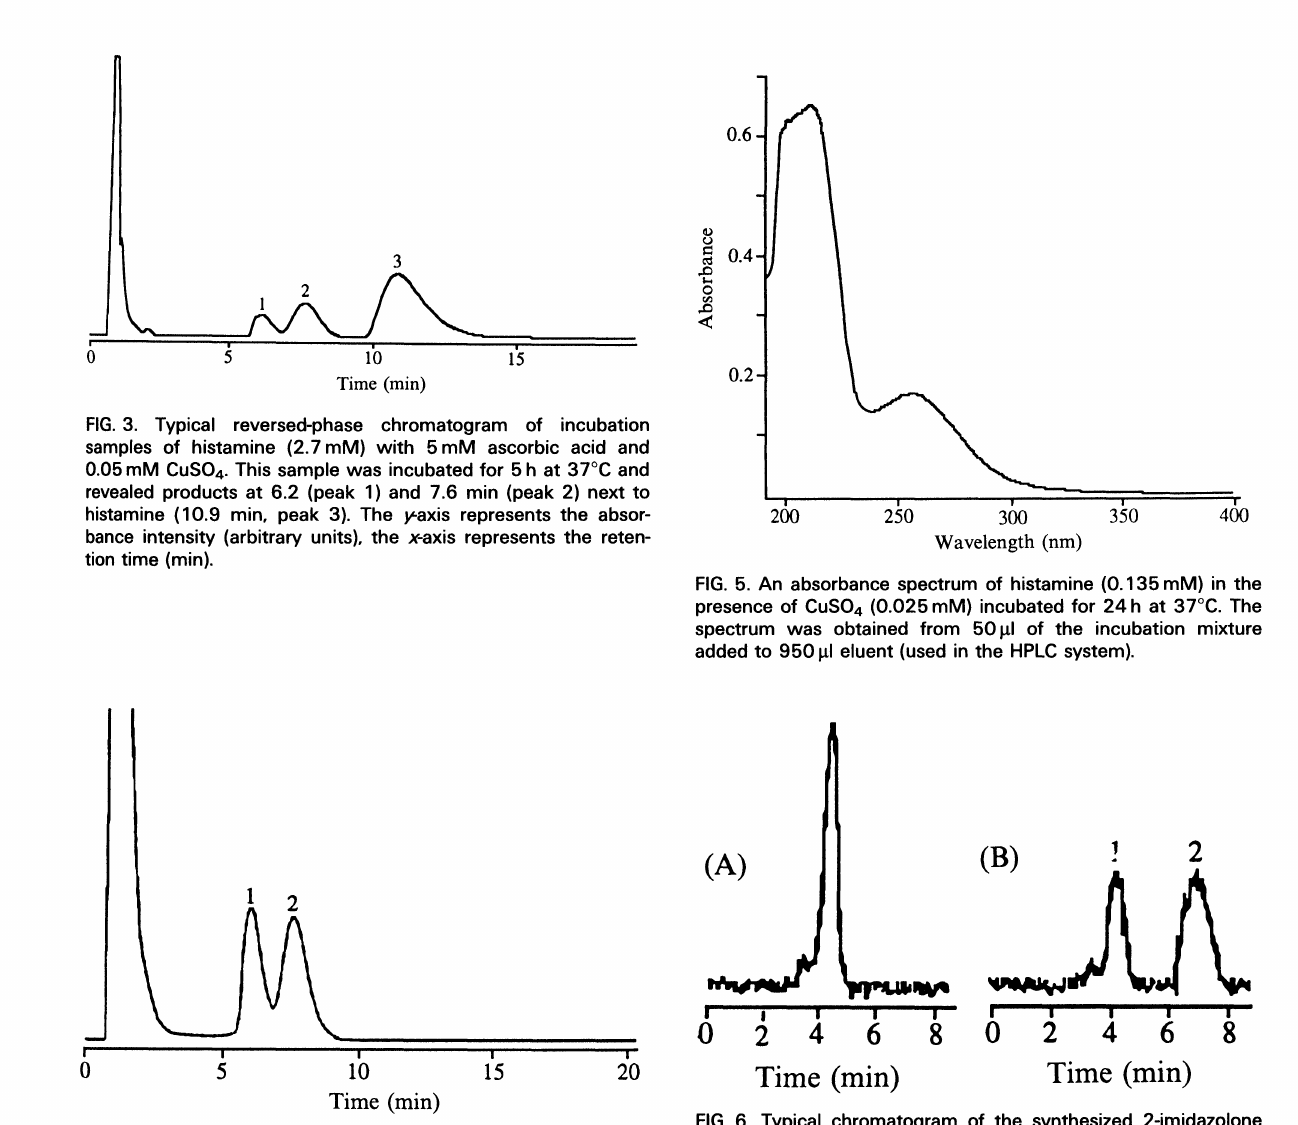
FIG. 6. Typical chromatogram of the synthesized 2-imidazolone derivative of histamine and the collected sample (at 6.0 min, see Fig. 2) after OPA derivatization. The synthesized 2-imidazolone derivative eluted at 4.4 min (A), the collected sample gave two products, one at 4.4 min (B, peak 1) and the other at 7.2 min (B, peak 2 histamine). The axis represents the fluorescence intensity (arbitrary units), the x-axis represents the retention time